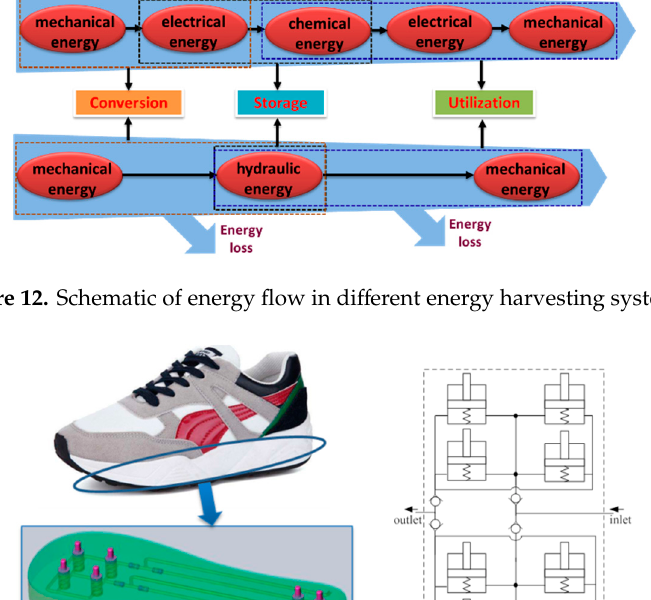
Figure 12. Schematic of energy flow in different energy harvesting systems.